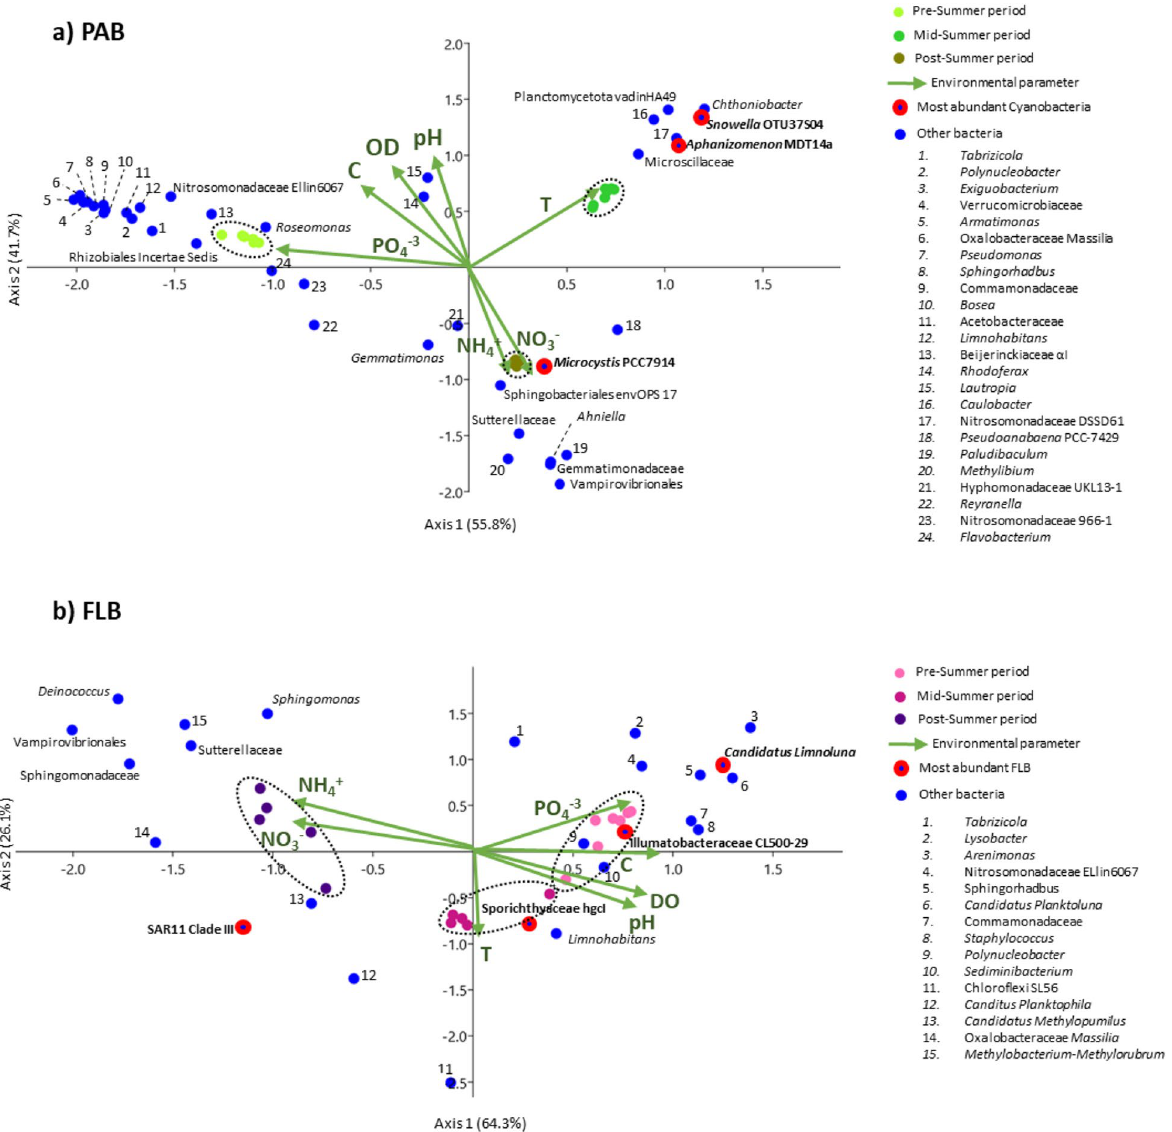
Figure 4. Canonical correspondence analysis (CCA) showing the relationships between bacterial community (OTUs) patterns and in situ environmental parameters in summer season. ( a ) particle-attached bacterial fraction (PAB), and ( b ) free-living bacterial fraction (FLB). Significant differences ( p < 0.05) between sampling periods were tested with